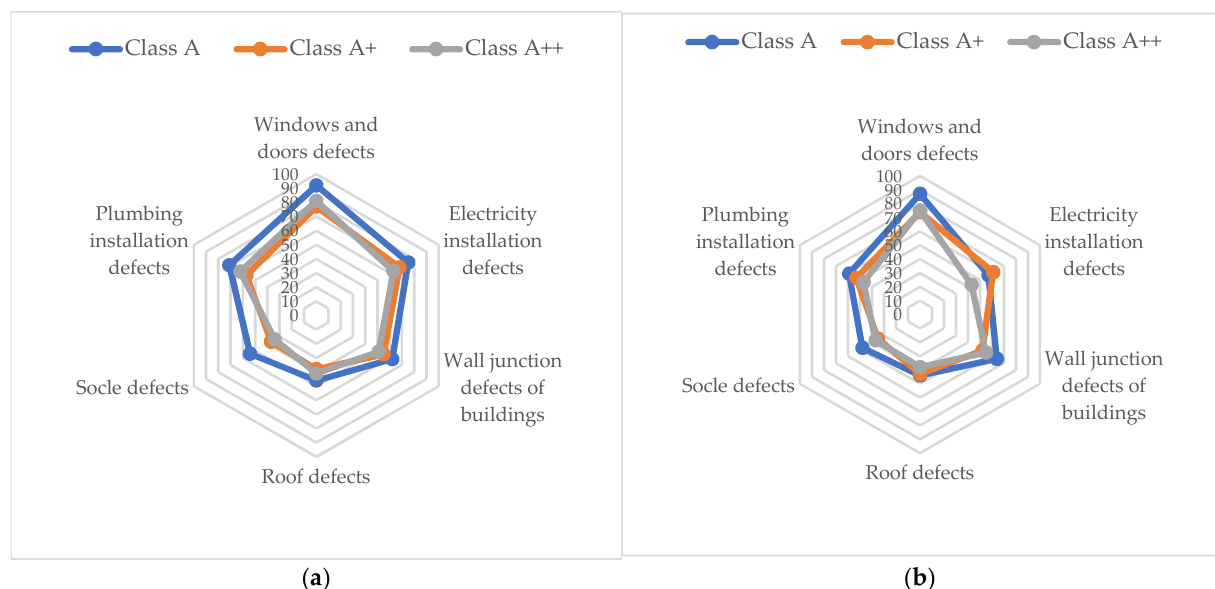
Figure 6. Frequency of defects for hollow clay masonry buildings ( a ) and sand–lime block masonry buildings ( b ).